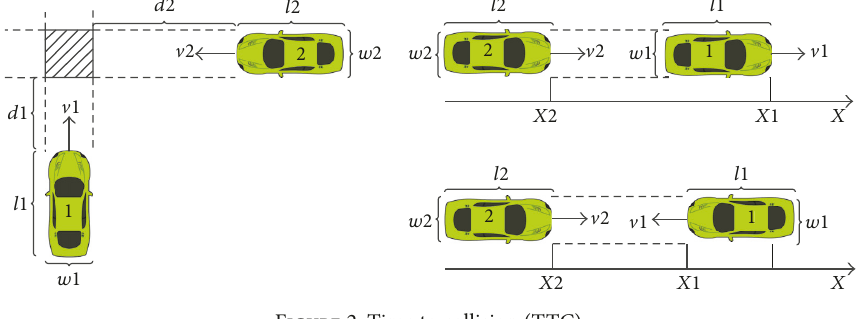
Figure 2: Time to collision (TTC).